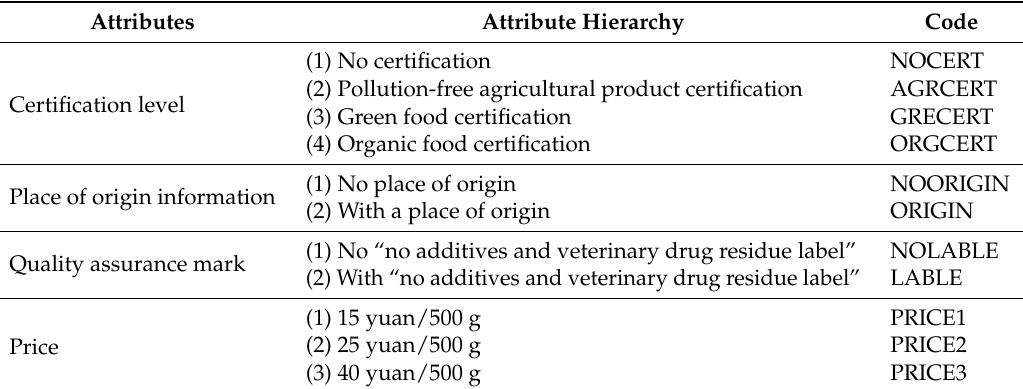
Table 1. The attributes and code settings of ham